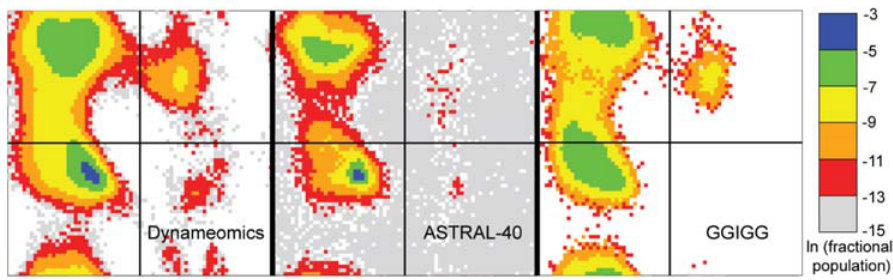
Figure 4 Ramachandran distributions for Ile in different structural contexts. Represented are Dynameomics native state simulations, static protein structures and simulation of a sterically unrestrained amino acid (in a GGIGG pentapeptide). ( F , c ) space (from -180 8 to q 180 8 ) is divided into 72 bins with a width of 5 8 . Each bin is colored by fractional population on a logarithmic scale. From left to right, distributions are shown for (i) all Ile residues in all time samples in the Dynameomics native state simulation set, (ii) all Ile residues present in the ASTRAL-40 dataset (v1.74) (42) and (iii) all time samples from simulations of the (acetylated and amidated) pentapeptide Gly-Gly-Ile-Gly-Gly (20).